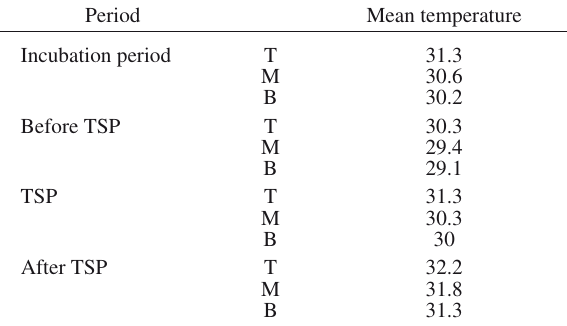
Table 5. – Mean temperature (°C) in different parts of the nest 13 during the incubation period. T, top; M, middle; B, bottom; TSP, thermosensitive period.